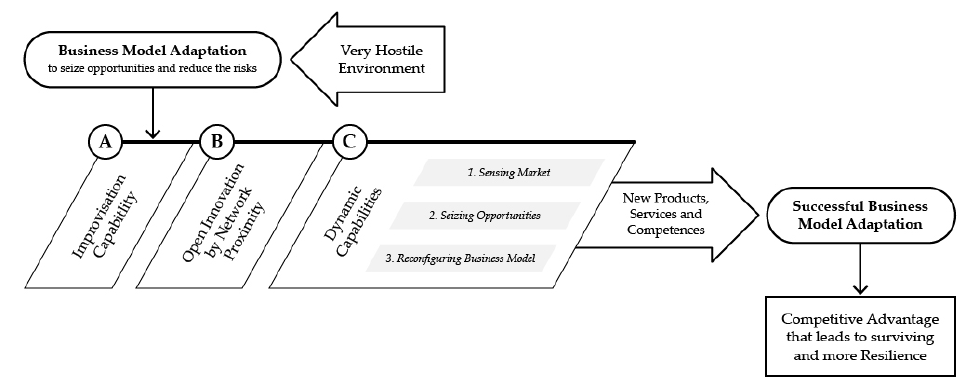
Figure 2. This research framework is the survival path to successful BMA of the firms in terms of the BM emergency management